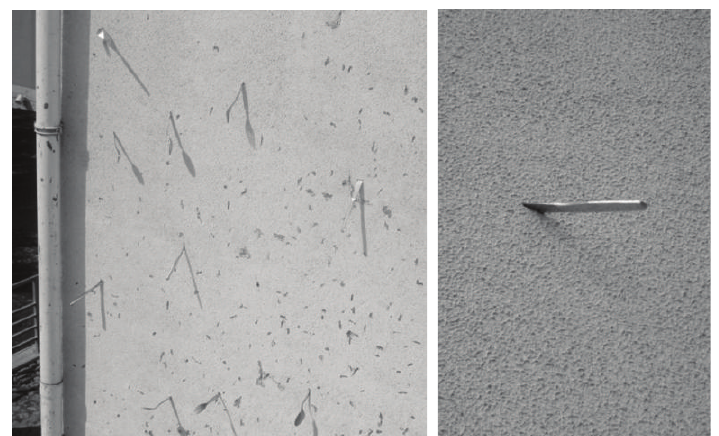
Figure 4: Damage of ETICS due to in-service impact (school building in Porto, Portugal).